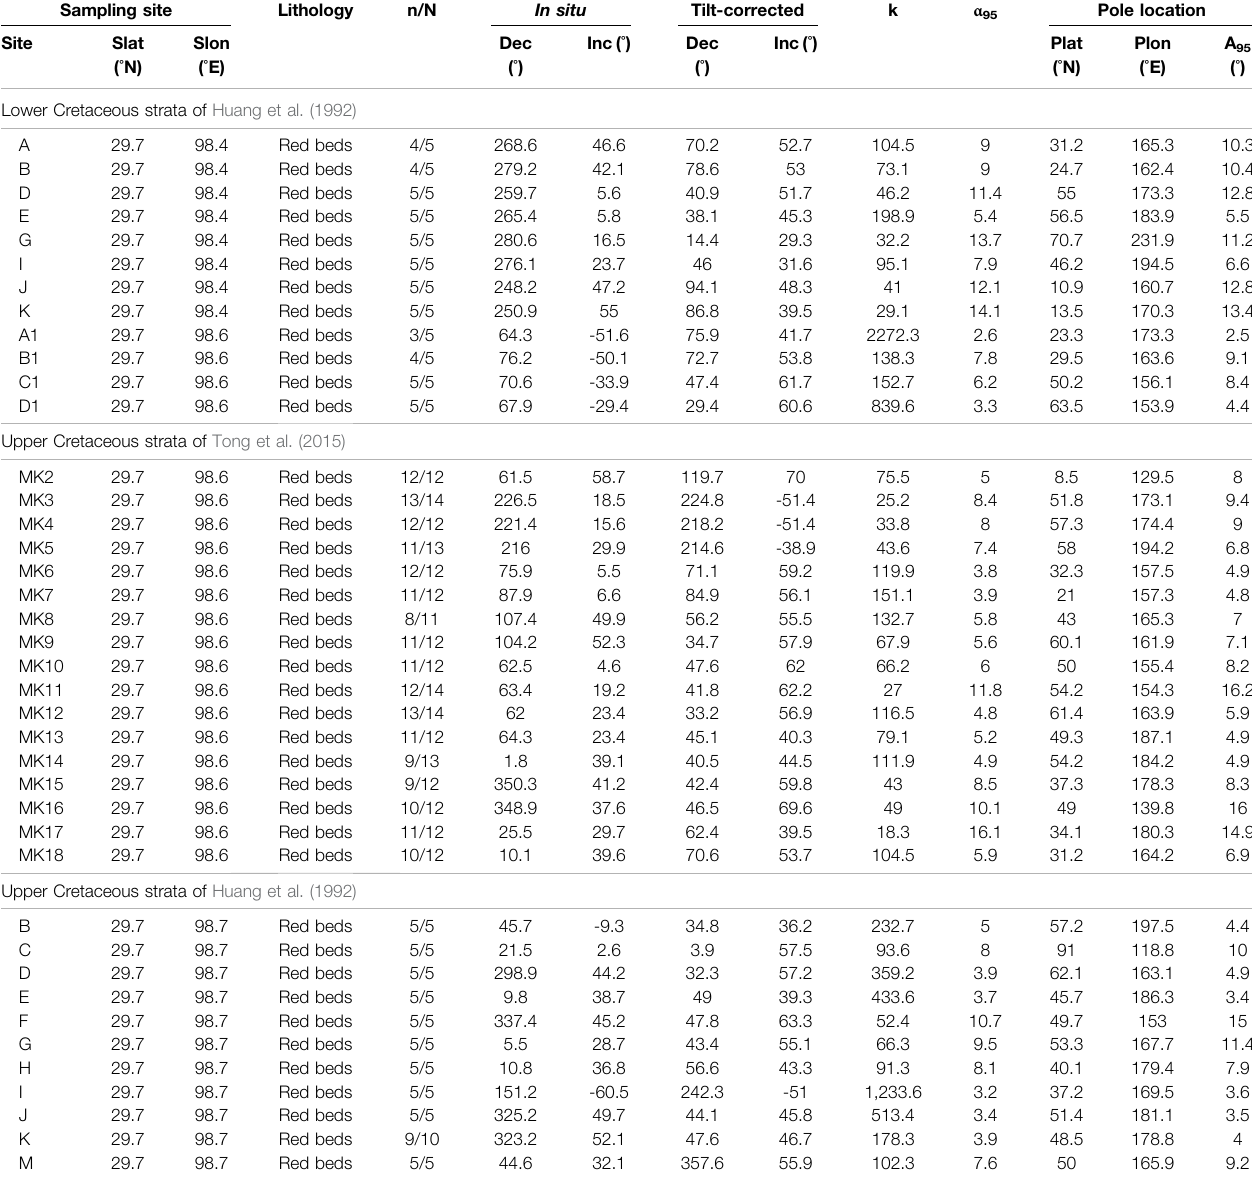
Mean paleomagnetic pole during K1: Plat. = 40.6 ° N, Plon. = 170.5 ° E, n = 12, K = 12.2, A 95 = 13.0 ° (Huang et al., 1992). Mean paleomagnetic pole during K2: Plat. = 48.9 ° N, Plon. = 168.1 ° E,n=28,K=19.9,A 95 =6.3 ° (Huangetal.,1992+;Tongetal.,2015).MeanpaleomagneticpoleduringK:Plat.=46.5 ° N,Plon.=168.9 ° E,n=40,K=16.6,A 95 =5.7 ° (Huangetal., 1992 +; Tong et al., 2015). N and n are number of samples collected and used for paleomagnetic calculation, respectively. Dec. and Inc. are declination and inclination, respectively; k is the Fisherian precision parameterforsamples (Fisher,1953); α 95 andA 95 arethe radiusofconeat 95%con fi dencelevelaboutthemean direction.Slat. andSlon. arelatitude andlongitudeofthesampling